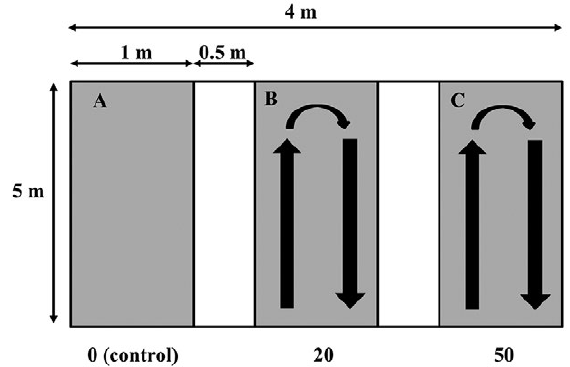
Fig. 4. – Digging experiment: lane A, control, 0 hoes; lane B, light pressure, intermittent, 20 hoes; lane C, heavy pressure, intermittent, 50 hoes; and lane D, continuous pressure, weekly, 20 hoes (4 times). In grey, experimental